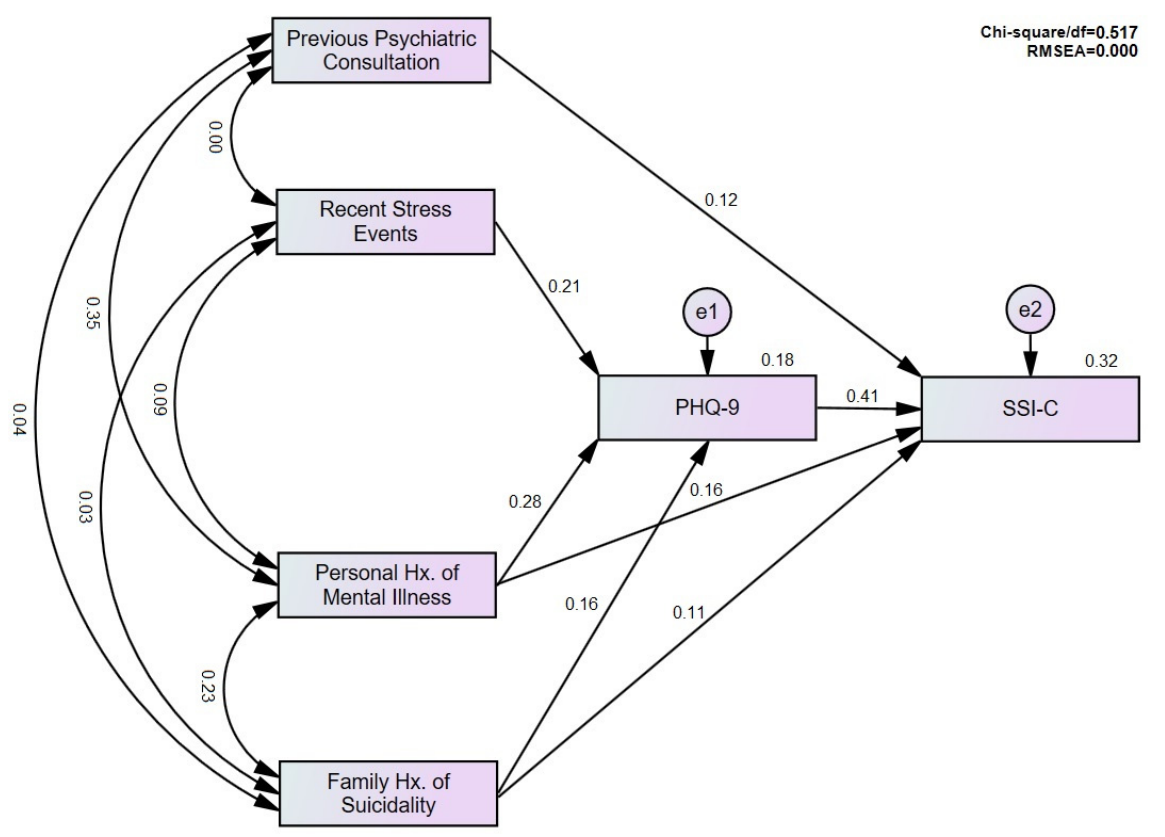
Figure 1. Path analysis and structural modeling. RMSEA: Root Mean Square Error of Approxima ‐ tion.